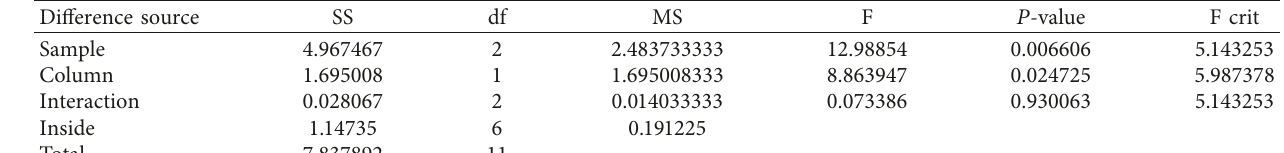
Table 10: Multivariate ANOVA for parameter B.